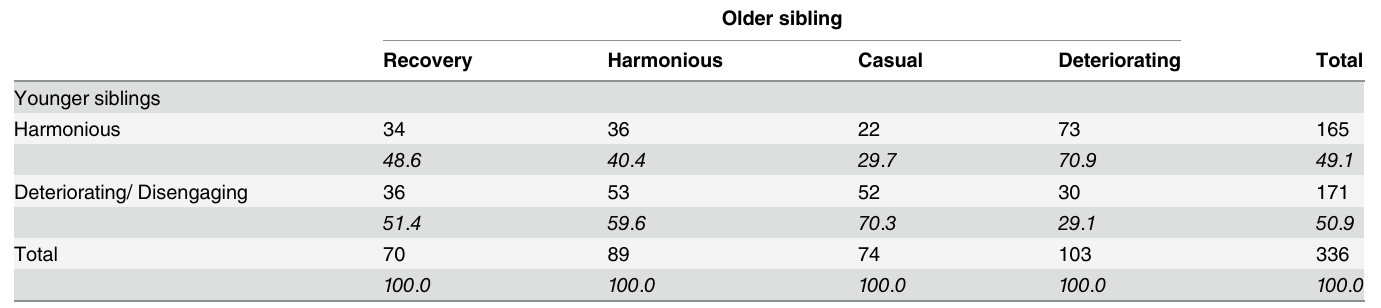
Table 4. Association between Modal Classes for Younger and Older